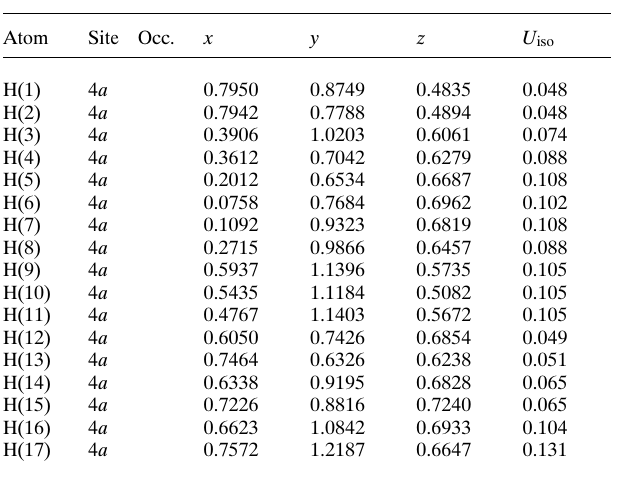
Table 2. Atomic coordinates and displacement parameters (in Å 2 )